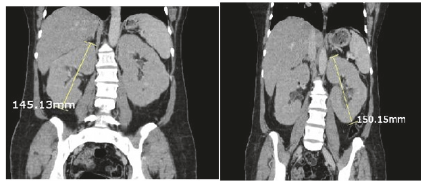
Figure 1: The enlargement of the kidneys bilaterally prior to chemotherapy.